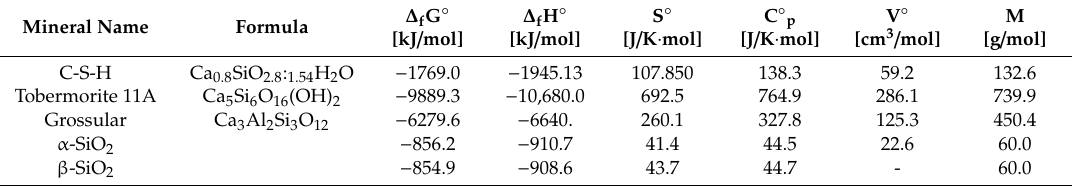
Table 2. Standard thermodynamic properties at 25 ◦ C and 1 bar. bricks [24,62].